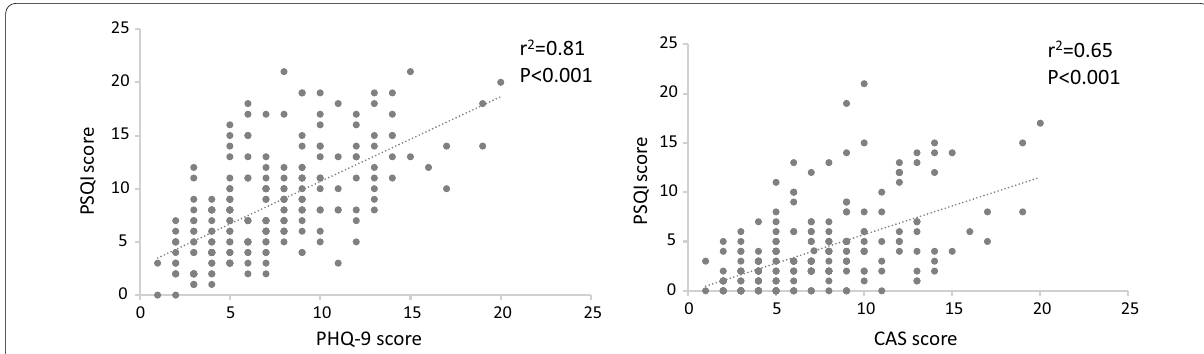
Fig. 2 Correlation between PSQI score, CAS and PHQ-9 score in patients with OSA during the pandemic